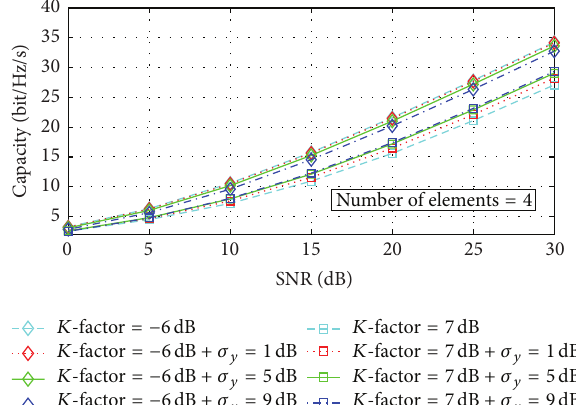
Figure 8: Capacity versus SNR for Rician plus shadowing fading with several 𝜎 and several 𝐾 -factor values.